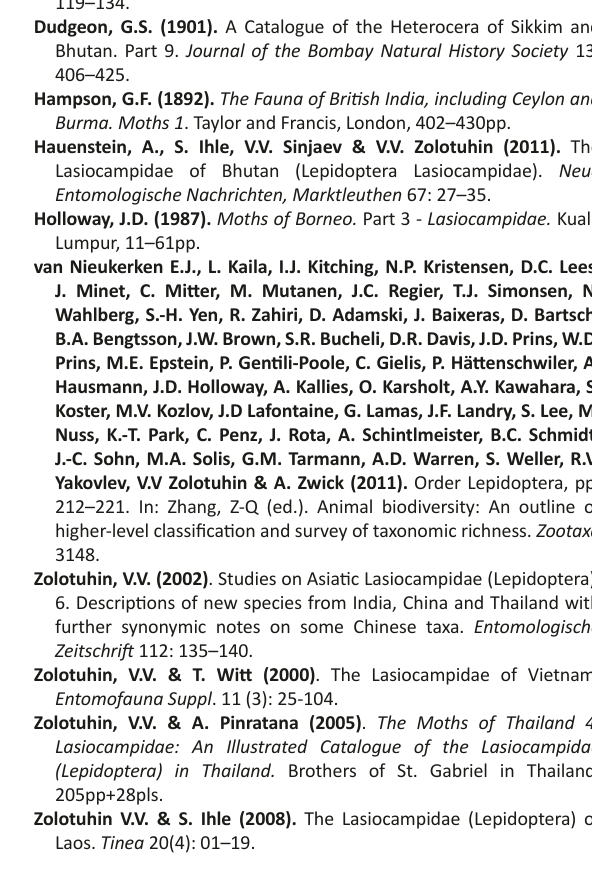
figs 8, 12. Type locality: Thailand, Chiang Mai, Doi Phahompok, 25km NW of Fang,